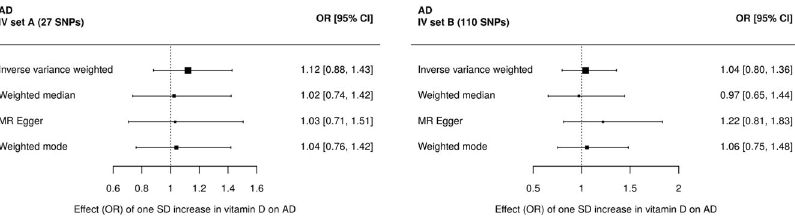
Fig. 2 Two-sample Mendelian randomization (MR) of vitamin D and a typical depression (AD). MR using ( a ) the 27 IVs from IV set A, from the GWAS of vitamin D in the UK Biobank split sample or ( b ) the 110 IVs from IV set B, from the previous GWAS of vitamin